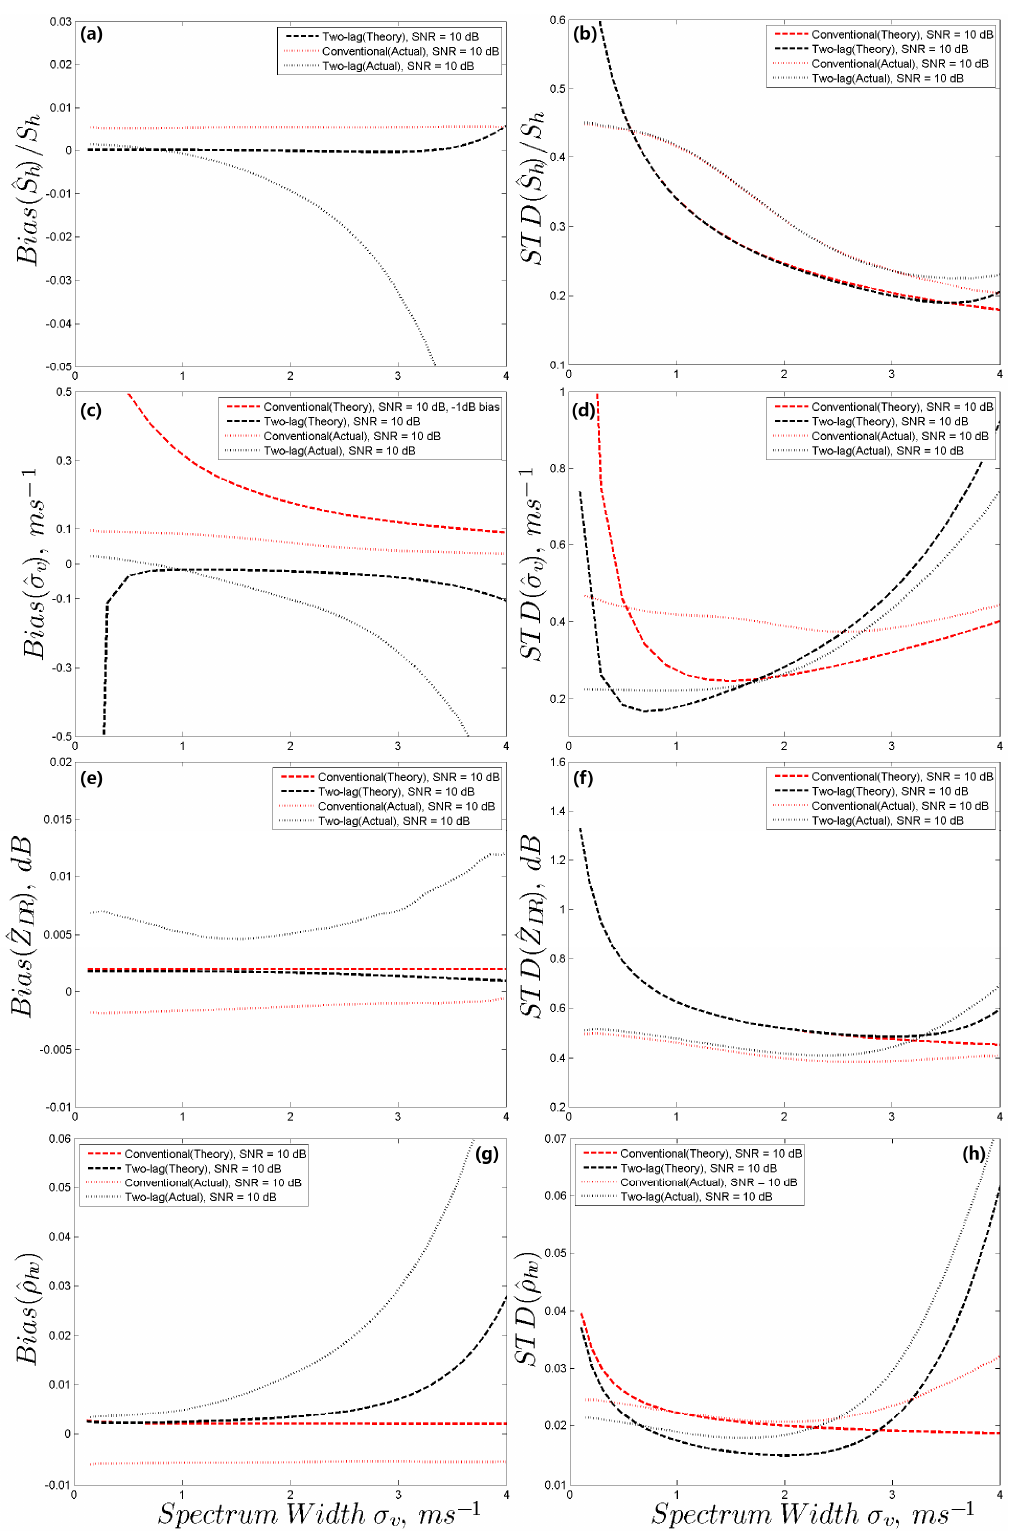
Figure 11. Comparison of bias and standard deviation of conventional and two-lag estimators from theoretical analysis and radar data statistics at SNR = 10 dB, ρ hv = 0.97, and Z DR = 1 dB. Four rows show performance of S h , σ v , Z DR and ρ hv , respectively. ( a ) Bias of S h ; ( b ) STD(S h ); ( c ) Bias of σ v ; ( d ) STD( σ v ); ( e ) Bias of Z DR ; ( f ) STD(Z DR ); ( g ) Bias of ρ hv ; and ( h ) STD( ρ hv ).